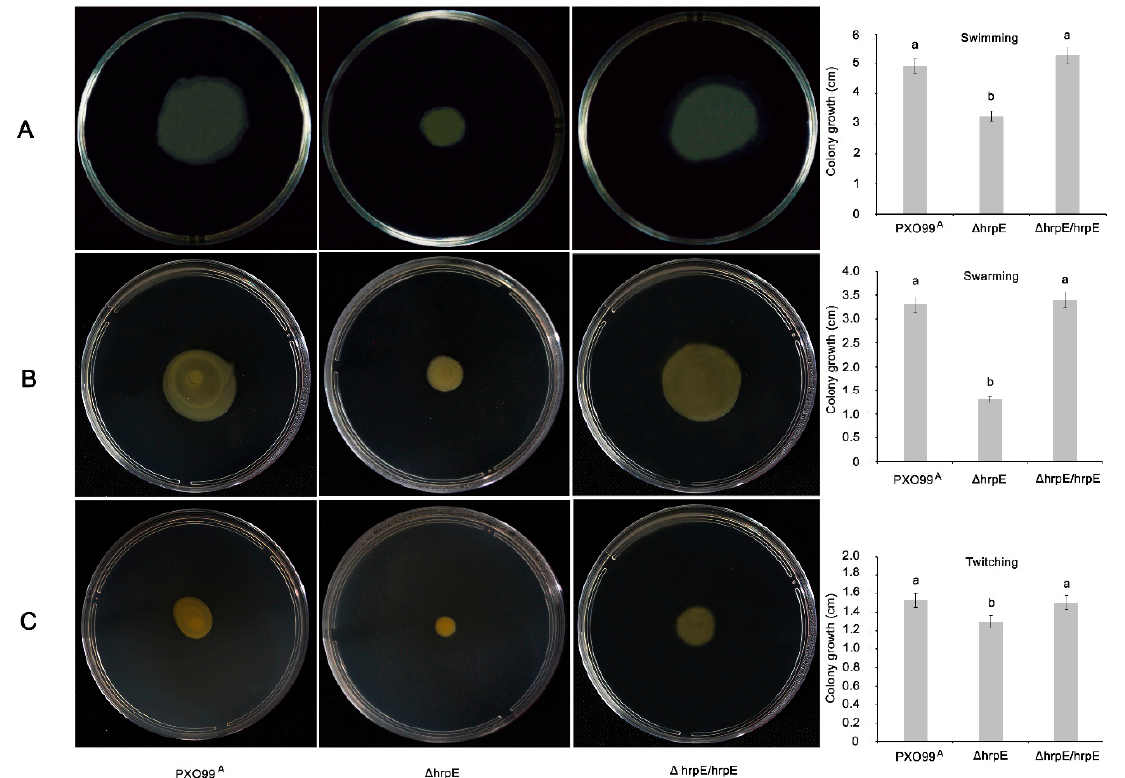
Figure 2. Effect of hrpE deletion on swimming, swarming and twitching motility. Swimming motility of different bacterial strains recorded 24 hours after inoculation ( A ), swarming motility of different bacterial strains recorded 24 hours after inoculation ( B ) and twitching motility of bacterial strains recorded 48 hours after inoculation ( C ). Error bars in graph indicate standard deviations of five replicates. Different letters on the bars describe significant differences at p < 0.05. All experiments were repeated thrice with similar results each time.